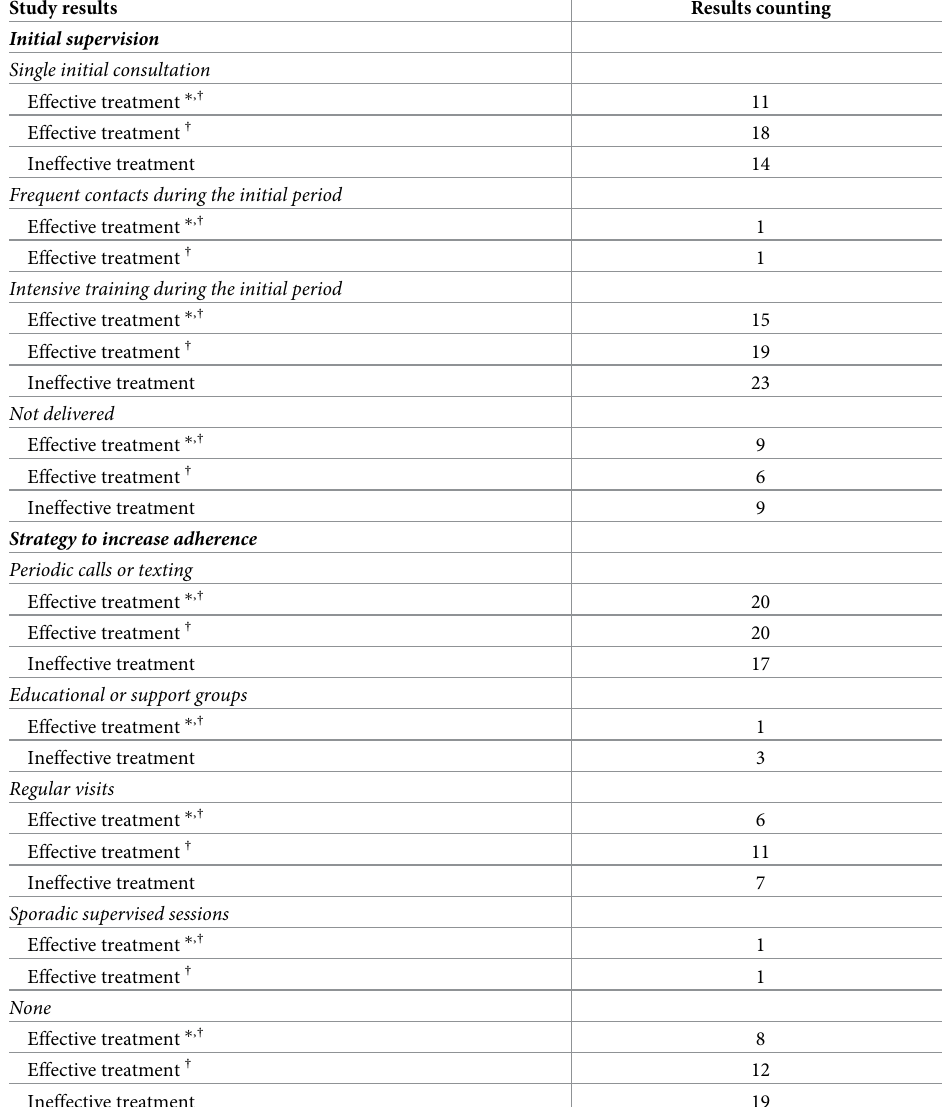
Table 5. Treatment efficacy (count), considering only